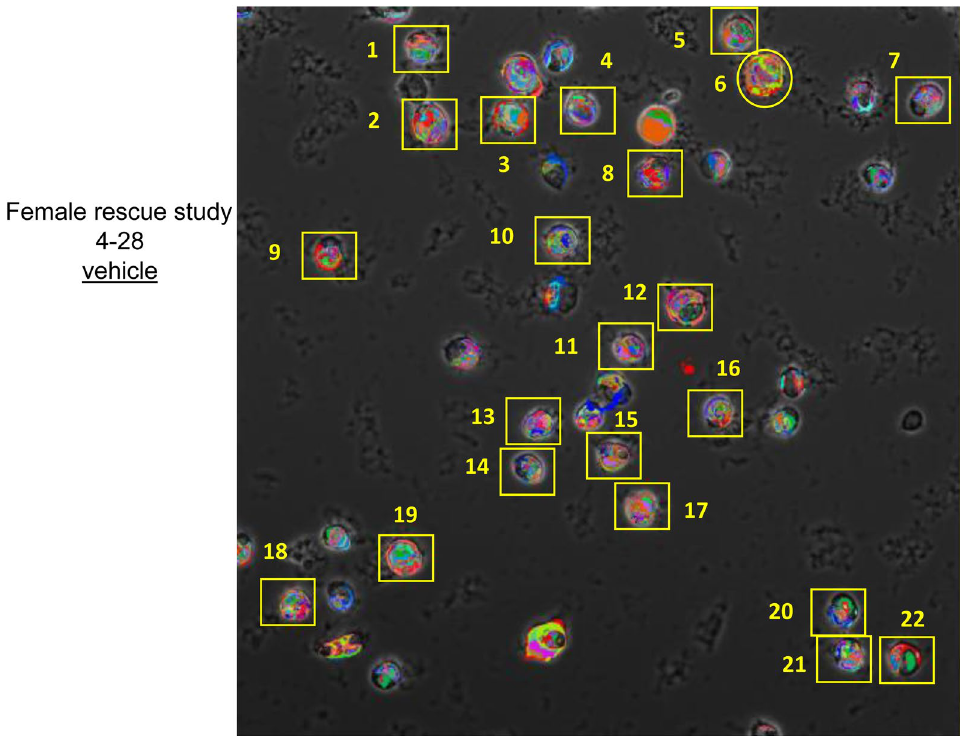
Figure 3. Selected cells. A representative image of one sample in this study is shown. Pseudocolors have been assigned by the TIS software to indicate different CMPs. The outlined cells (n = 22) have been selected and their coordinates determined for single cell analysis.